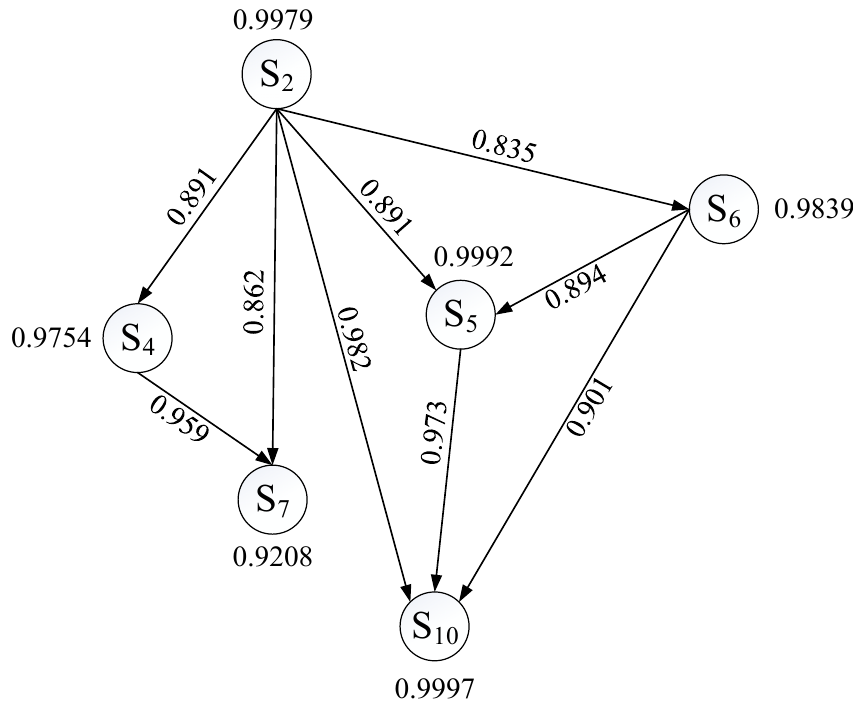
Figure 6. Similarity graph of missing data source.